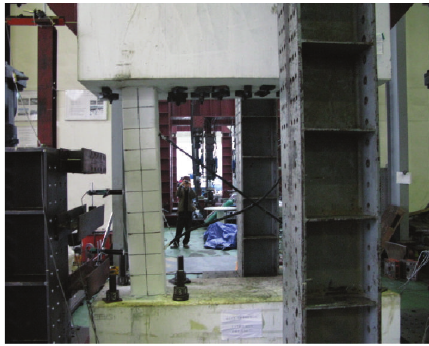
Figure 11: The SF-R2 specimen following the cyclic loading tests.